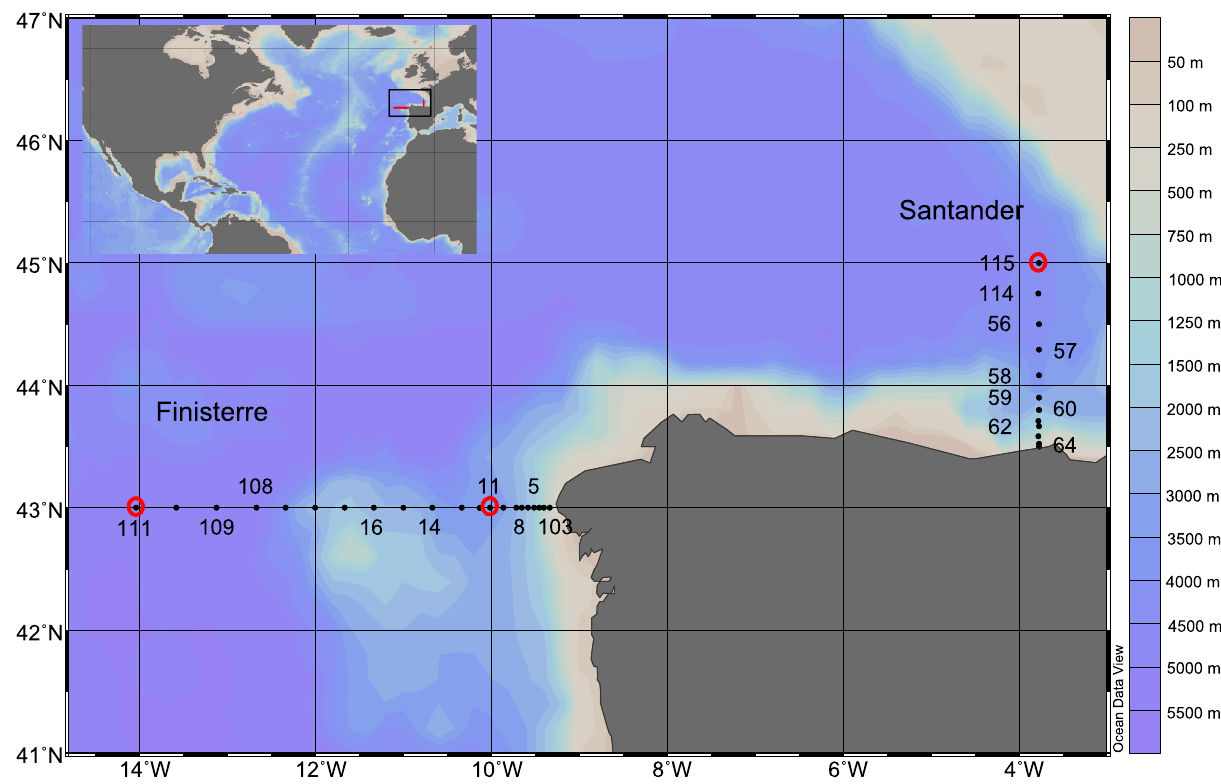
Figure 1. Location of the sampling stations along Finisterre and Santander sections during the MODUPLAN 0814 cruise. Black dots indicate the stations in which hydrographic features of the water column were measured (see Supplementary Information, Fig. S1). The numbers indicate the stations in which leucine incorporation rate (LIR) was measured. The experiments to determine empirical leucine-to-carbon conversion factors (eCFs) were carried out at biological stations 11, 111 and 115 (highlighted with a red circle). Bacterial diversity and the quality and quantity of DOM were determined at stations 11 and 115.